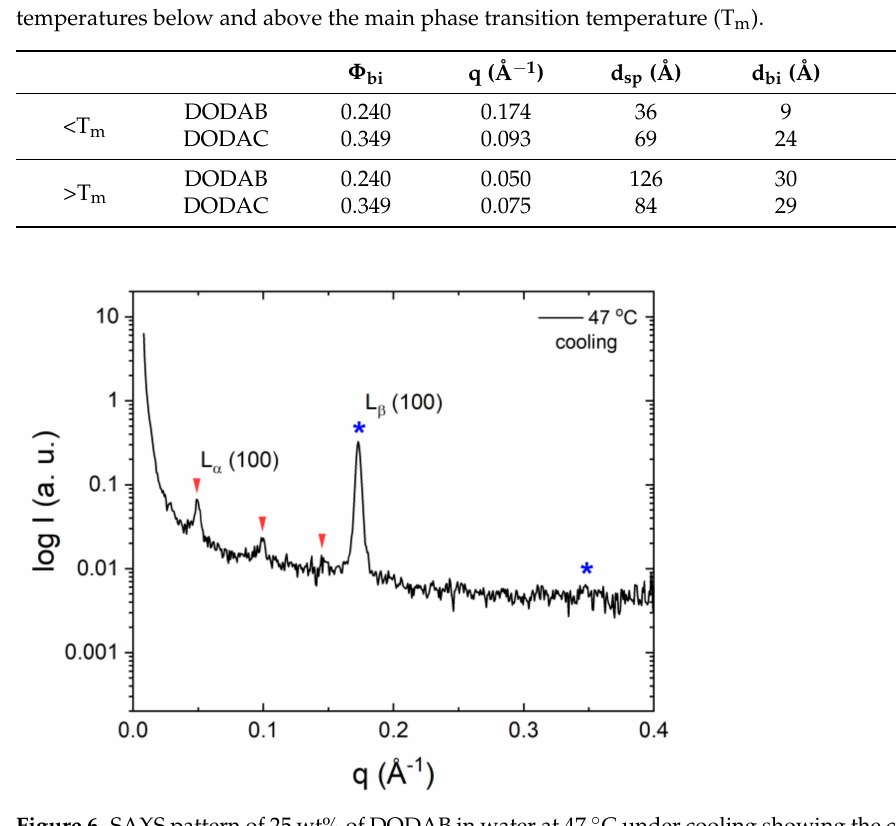
Figure 6. SAXS pattern of 25 wt% of DODAB in water at 47 ◦ C under cooling showing the coexistence of two lamellar phases. The symbols represent lamellar reflections; arrows the liquid crystalline phase and stars the gel